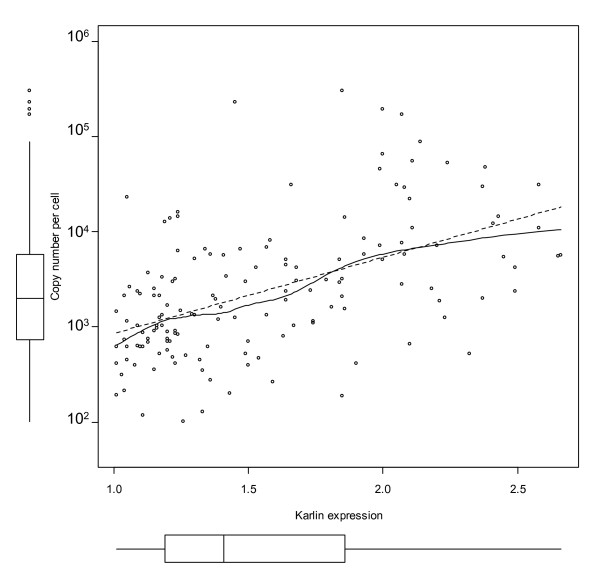
Karlin's predicted gene expression and measured protein abundance. The dotted line is linear regression and the solid line a loess local fitting curve. The Pearson correlation coefficient between log(copy number) and Karlin's expression value is 0.52 (p-value < 10-12) and the Spearman's rho is 0.53 (p-value < 10-12).